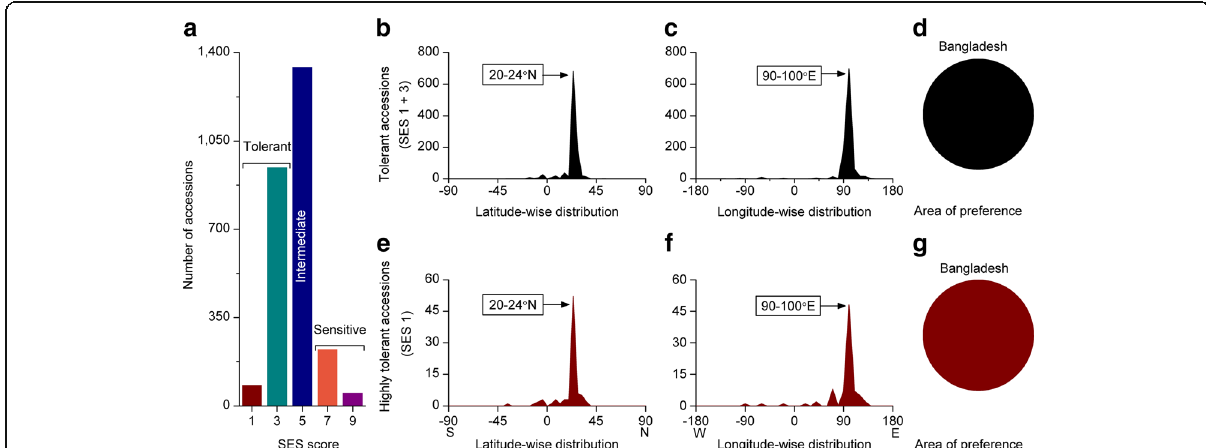
Fig. 2 Geographic distribution pattern of alkali tolerant rice accessions. a Extent of alkali tolerant accessions, b - d Geographic distribution pattern of alkali tolerant (SES score 1-3) accessions, b Latitude-wise distribution, c Longitude-wide distribution, d Area of preference, e - g Geographic distribution pattern of highly alkali tolerant (SES score 1) accessions, e Latitude-wise distribution, f Longitude-wide distribution, g Area of preference. List of highly tolerant accessions can be found in Additional file 4: Table